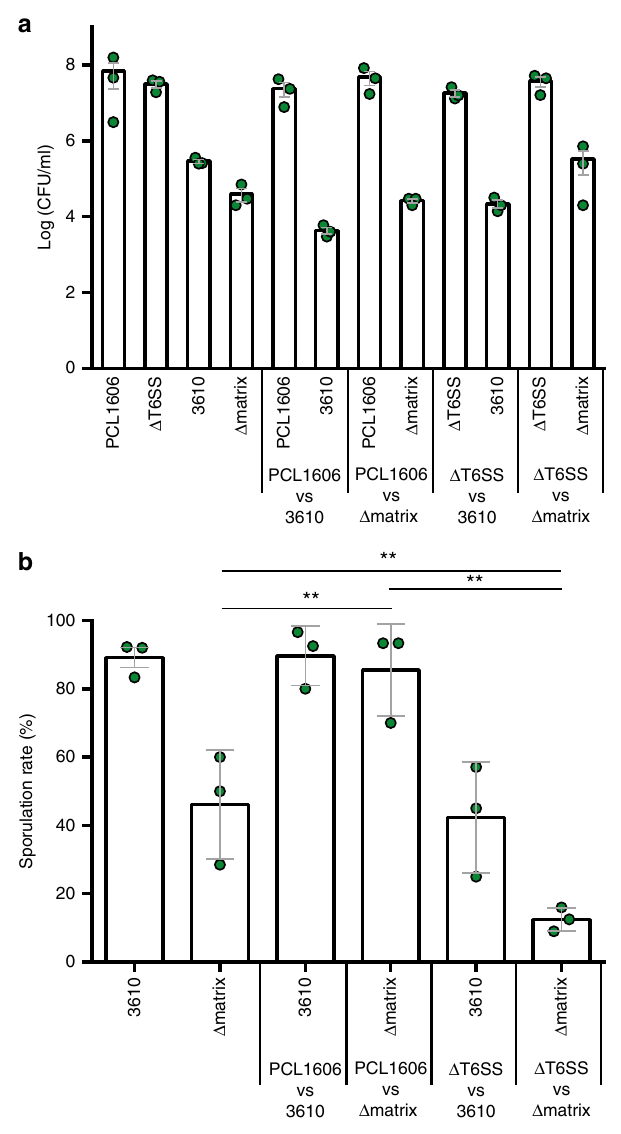
Fig. 9 The T6SS affects Bacillus growth and sporulation in melon seed radicles. a Log (CFU/ml) of B. subtilis (3610 and Δ matrix) and P. chlororaphis (PCL1606 and Δ T6SS) strains after single- and co-bacterization of melon seeds. b Sporulation percentages of Bacillus subtilis strains after single- or co-inoculation with Pseudomonas strains of melon seeds. Colony-forming units and spore percentages of Bacillus were counted 5 dpi. Average values of four biological replicates are shown, with error bars representing